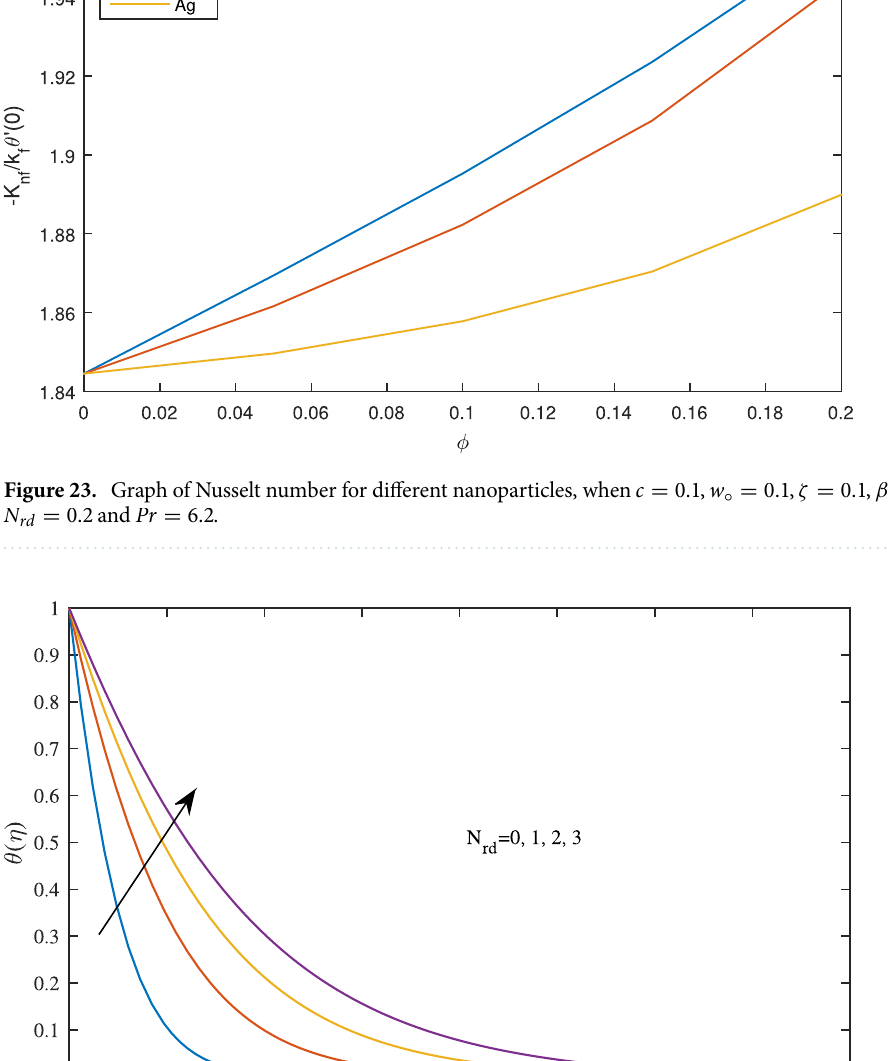
0.5 , ζ 1 , 0.1 , β 0.2 , c ◦ = = = =